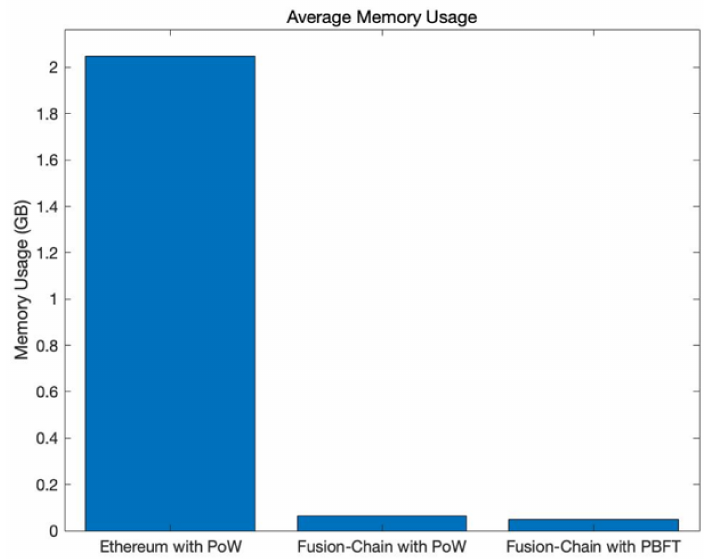
Figure 9. Memory usage comparison.